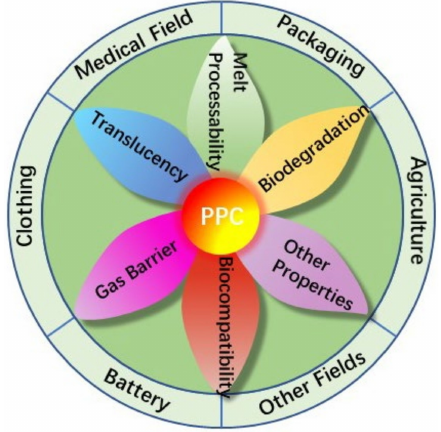
Figure 8. Application areas of PPC. (Style referenced from